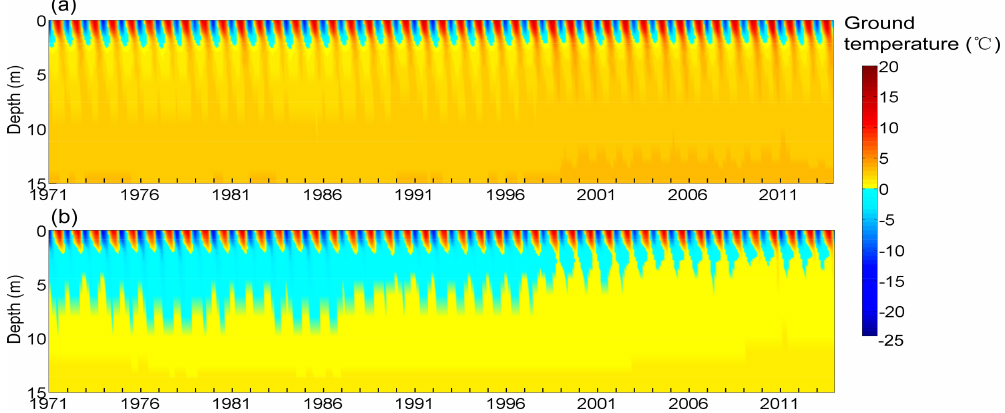
Figure 10. Spatially averaged monthly ground temperatures simulated from 1971 to 2013 for two elevation intervals: (a) seasonally frozen ground between 3300 and 3500m; (b) permafrost that degraded to seasonally frozen ground between 3500 and